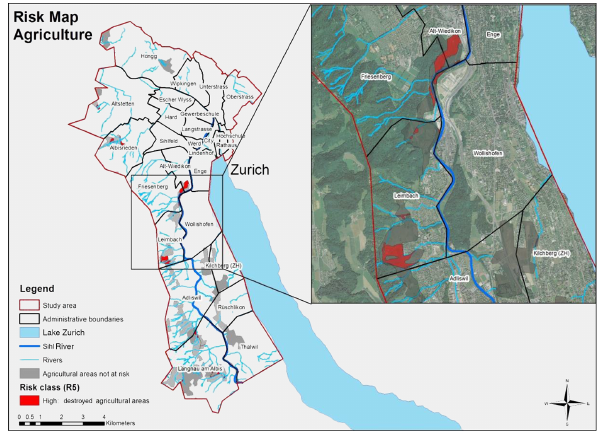
Table 14. Relative risk classes and range of values for agriculture.